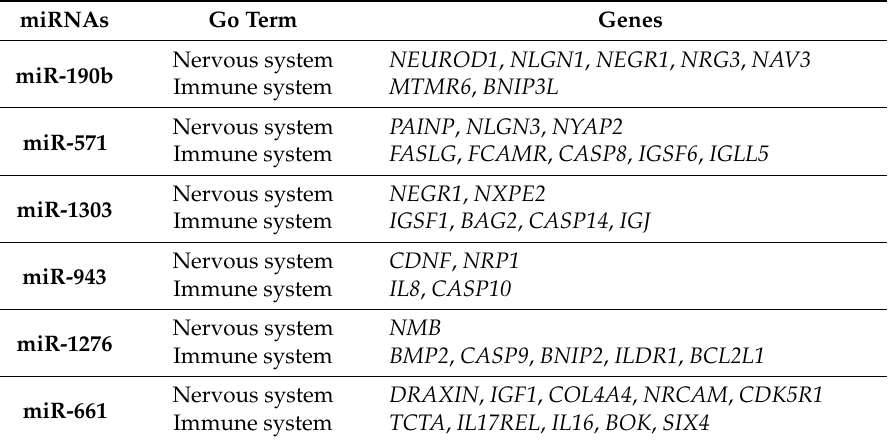
Table 4. Genes predicted to be targeted by the candidate miRNAs.